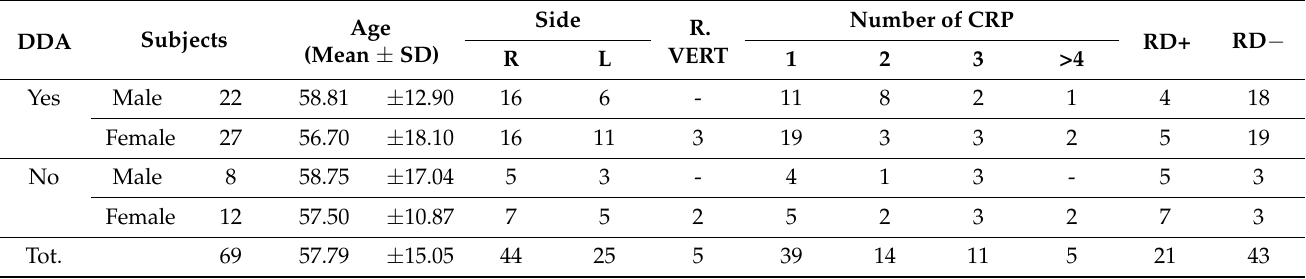
Table 1. Demographic Data. DDA: Recovery of dynamic daily activities; SD: standard deviation; R: Right; L: Left; R.VERT: Relapse of vertigo; CRP: Canalith repositioning procedure; RD+: Residual dizziness